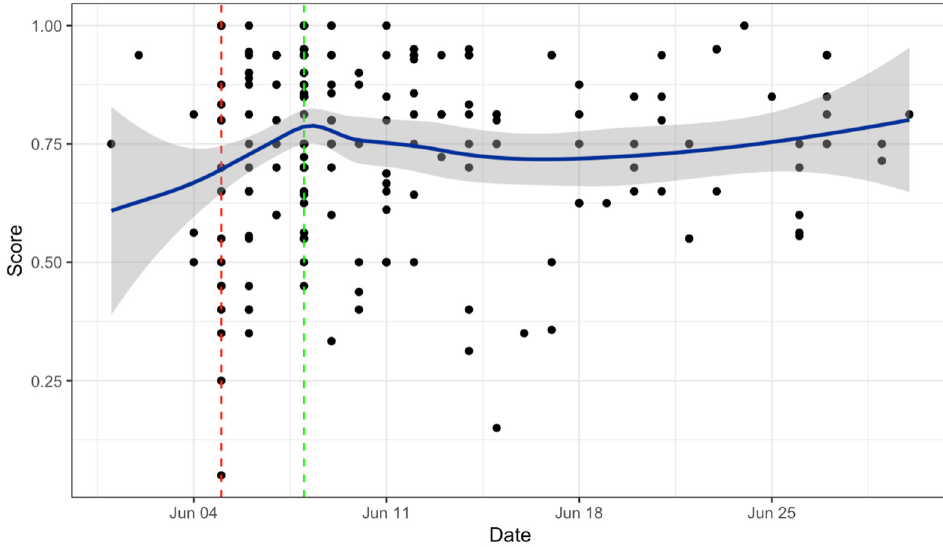
Figure 6. TEMPOS scores over time. Red and green dashed lines represent the deaths of Kate Spade and Anthony Bourdain, respectively.